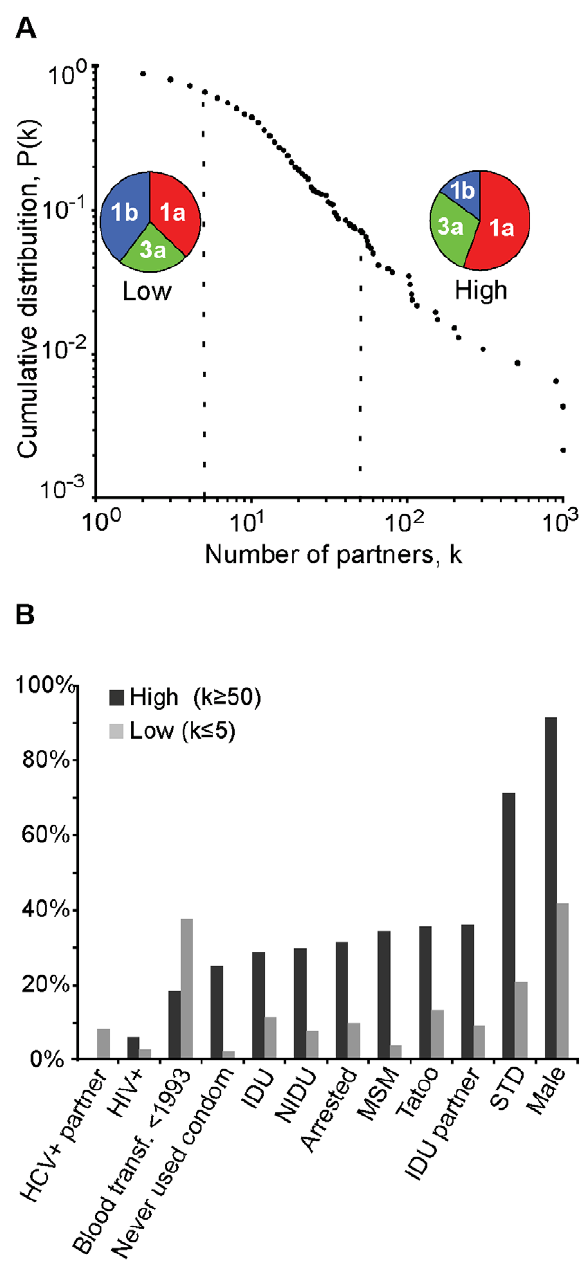
Figure 4. Scale-free sexual contact network of HCV carriers. A ) The cumulative frequency distribution P ( k ) versus the number of partners ( k ) shows that the low connectivity end of this network (individuals with 5 or less sexual partners) is associated with a higher prevalence of HIV-1b infected individuals compared to the high connectivity heavy tail-end of the network, which is in turn more frequently associated by HCV-1a and 3a carriers. B ) Social, clinical and transmission risk factors are shown in increasing frequency in relation to the high-connectivity group that includes all HCV patients with 50 or more sexual contacts (dark grey) compared to the low-connectivity group that includes all HCV patients with 5 or less sexual contacts (light grey). The final two columns on the right show a preponderance of males with increased risk factors and behaviors. The high frequency of blood transfusions among the low-connectivity group shows its importance for HCV transmission among the general population at large up until the early